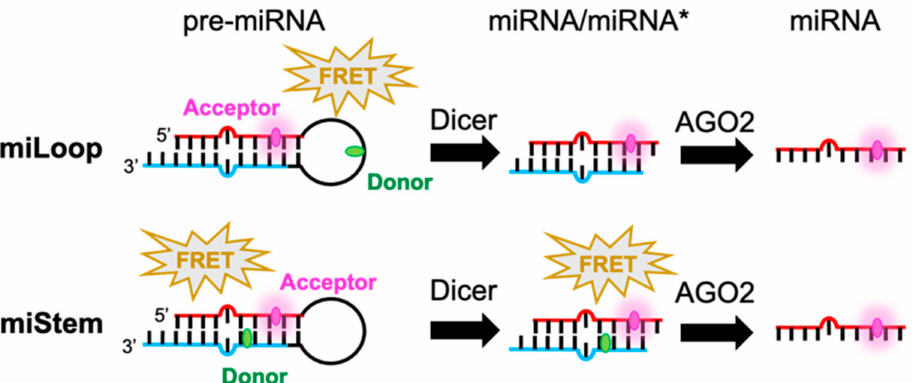
Scheme 1. Schematic illustration of FRET-modified pre-miRNAs in which the signals are switched by Dicer (miLoop) or AGO2 (miStem) that was designed here. The FRET signal of miLoop was canceled upon removing the loop region by the Dicer. Regarding miStem, the FRET signal was canceled by the dissociation of miRNA* by AGO2, while FRET could be observed from pre-miRNA and